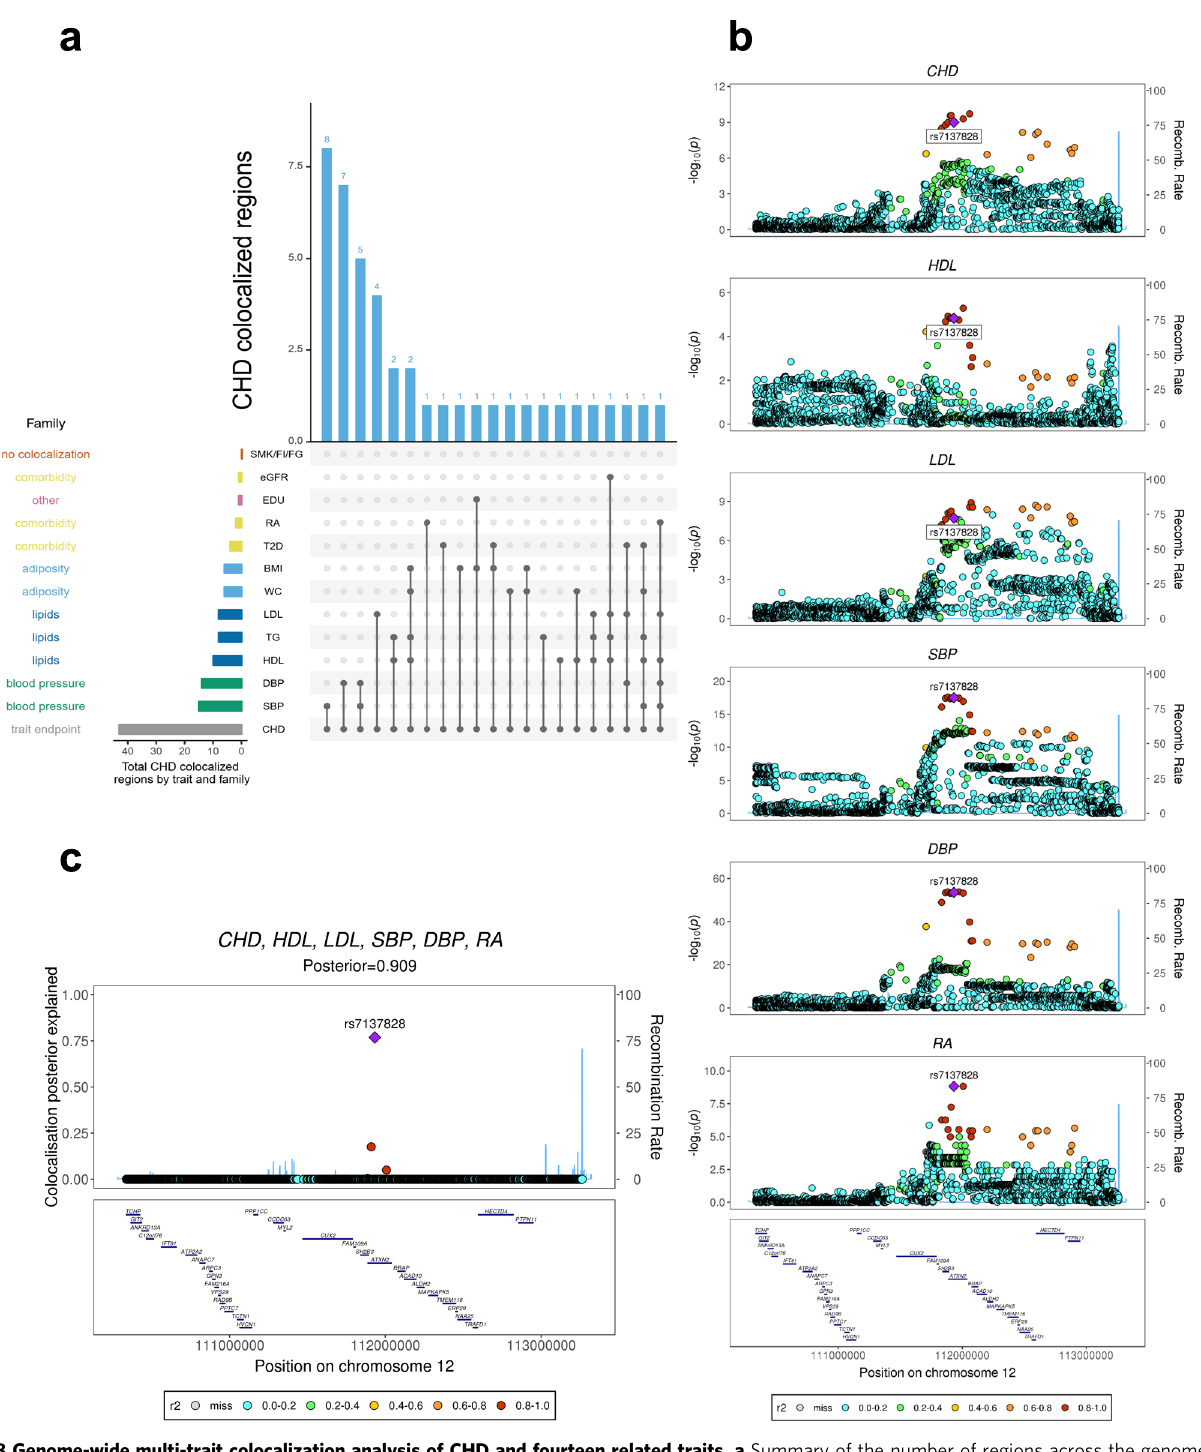
Fig. 8 Genome-wide multi-trait colocalization analysis of CHD and fourteen related traits. a Summary of the number of regions across the genome in which CHD colocalizes with at least one related trait. Results are aggregated by trait family, e.g. major lipids, and by each individual trait (see Supplementary Table S1 for a list of trait abbreviations). b Stacked association plots of CHD with high-density lipoprotein (HDL), low-density lipoprotein (LDL), systolic blood pressure (SBP), diastolic blood pressure (DBP) and rheumatoid arthritis (RA). HyPrColoc implicated both the SH2B3-ATXN2 locus and risk variant rs713782, both of which have been previously reported as associated with CHD risk 26 . However, HyPrColoc extended this result by identifying that the risk loci and variant are shared with 5 conventional CHD risk factors 11 . SNPs in stronger LD with the putative causal SNP rs713782 appear darker in the plot. c HyPrColoc identi fi ed rs713782 as a candidate causal variant explaining the shared association signal between CHD and the 5 related traits. The posterior probability of colocalization between the traits was 0.909 and rs713782 explained over 76% of this, i.e. the posterior probability of rs713782 being the shared causal variant is 0.909 × 0.76 = 0.69. The next candidate variant explained <20%.